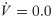
Performance of the antithetic controller when the compensatory flux is homogeneously generated within the cellular volume (Eqs 56 and 22–27).Phase 1: constant volume V and constant k3. Initial concentrations and rate constant values: V0 = 25.0, V˙=0.0, A0 = 0.0, E1,0 = 0.0, E2,0 = 0.0, M0 = 2 × 105, N0 = 1 × 106, O0 = 2 × 105, k2 = 1.0, k3 = 2.0, k3˙=0.0, k4 = 10.0, k5 = 1 × 10−6, k6 = 20.0, k7 = 1 × 10−5, k8 = 20.0, k9 = 1 × 10−5. The controller moves A to Asettheor=(k8/k4)=2.0 (Eq 57 when k3˙=0). Phase 2: rate constants remain the same as in phase 1, but V increases linearly with V˙=2.0, while k3 remains constant at k3 = 2.0. The controller is able to maintain A at Asettheor=k4/k6=2.0 in agreement with Eq 57. Phase 3: V continues to increase with the same speed while k3 now linearly increases with k3˙=1.0. As indicated by Eq 57 the controller is no longer able to keep A at Asettheor but shows a constant steady state value below its theoretical set-point.